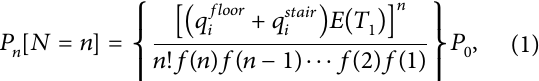
Figure 1: Structure and structure name of the